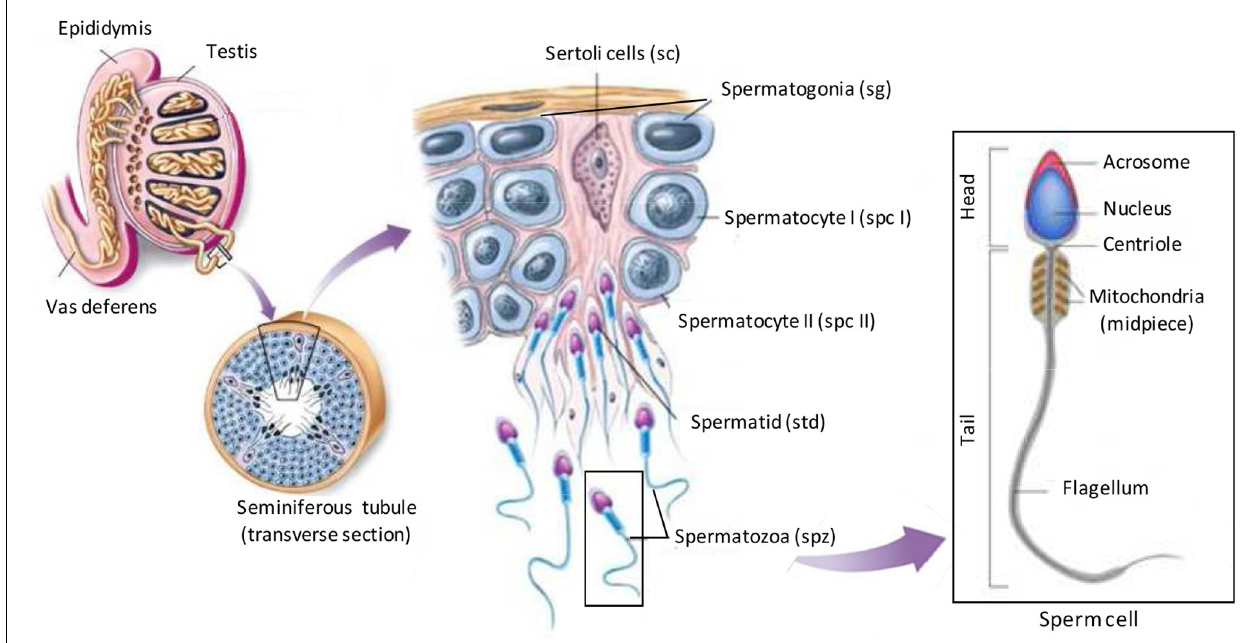
FIGURE 4 | Illustration of spermatogenesis. Spermatogenesis occurs within the seminiferous tubules of the testes of a post pubescent male. Diploid primordial germ cells (also called spermatogonia; sg) near the basal lamina of the seminiferous tubules undergo an initial mitotic division to produce diploid primary spermatocytes (spc I). Nearly half the primary spermatocytes produced remain near the basal lamina to continue to divide mitotically, thus allowing spermatogenesis to be continuous during male’s reproductive lifespan. Other primary spermatocytes migrate toward the lumen of the seminiferous tubules and begin to undergo meiosis I, resulting in haploid secondary spermatocytes (spc II). These secondary spermatocytes further